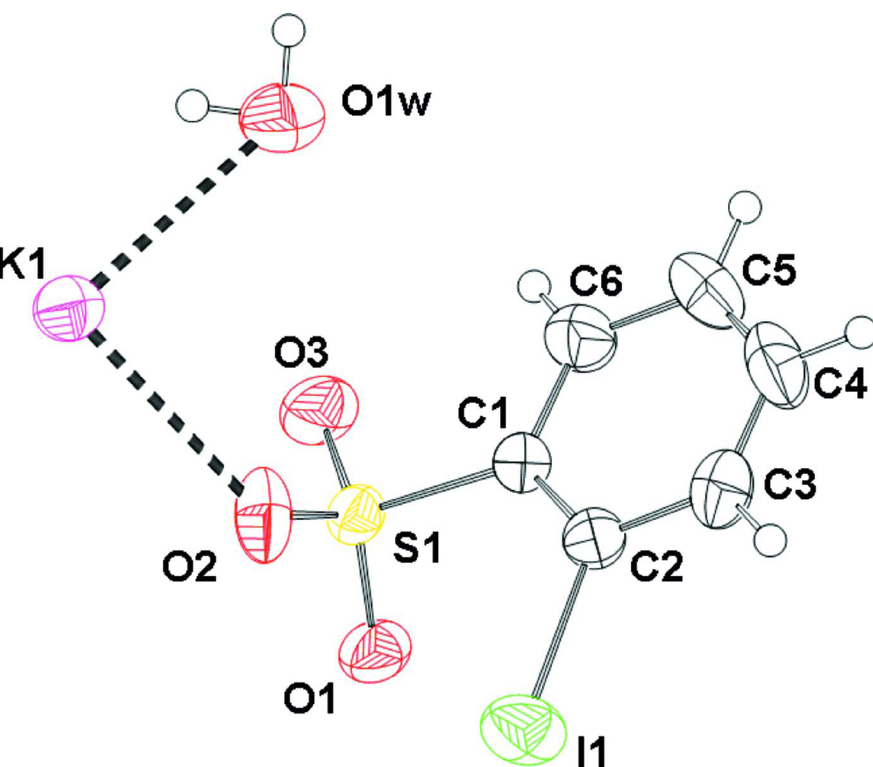
The molecular structure of the title compound, showing the atom numbering scheme and displacement ellipsoids drawn at the 50% probability level [The K···O contacts are shown as a dashed